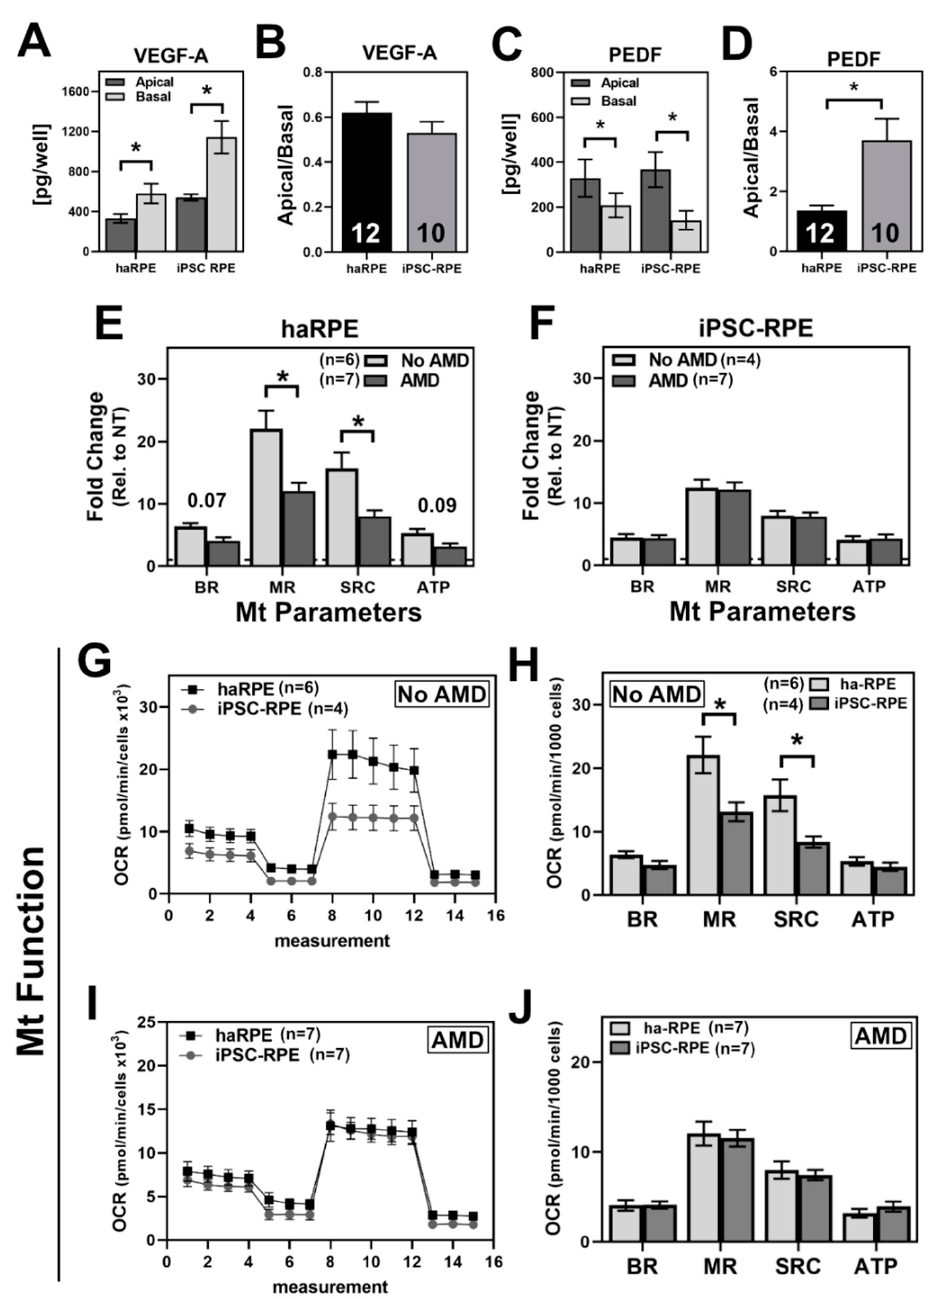
(Figure 1B). When comparing the ratio of apical/basal PEDF, iPSC-RPE had ~2.5-fold increase relative to haRPE (Figure 1D).